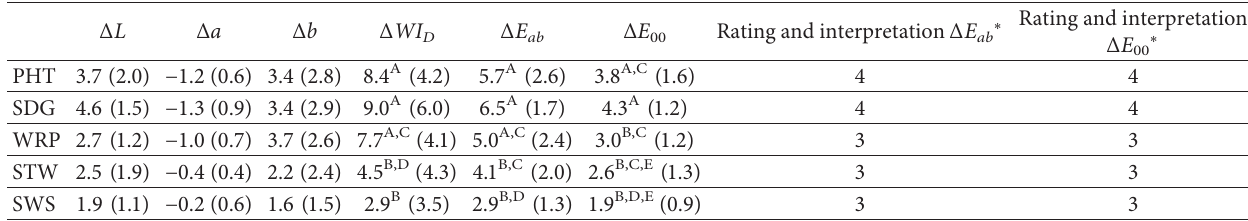
N � 25evaluated teeth perexperimental group. Capital letterscompareenamel color changes ( Δ WI D , Δ E ab , and Δ E 00 ) ateach time point (columns), according to one-way ANOVA and Tukey post hoc test ( Δ WI D , Δ E ab , and Δ E 00 ). Different capital letters, A and B; C and D; E and F: significant ( p < 0 . 05). ∗ Grades: (1) not effective; (2) moderately effective; (3) good effectiveness; (4) very good effectiveness; (5) excellent effectiveness